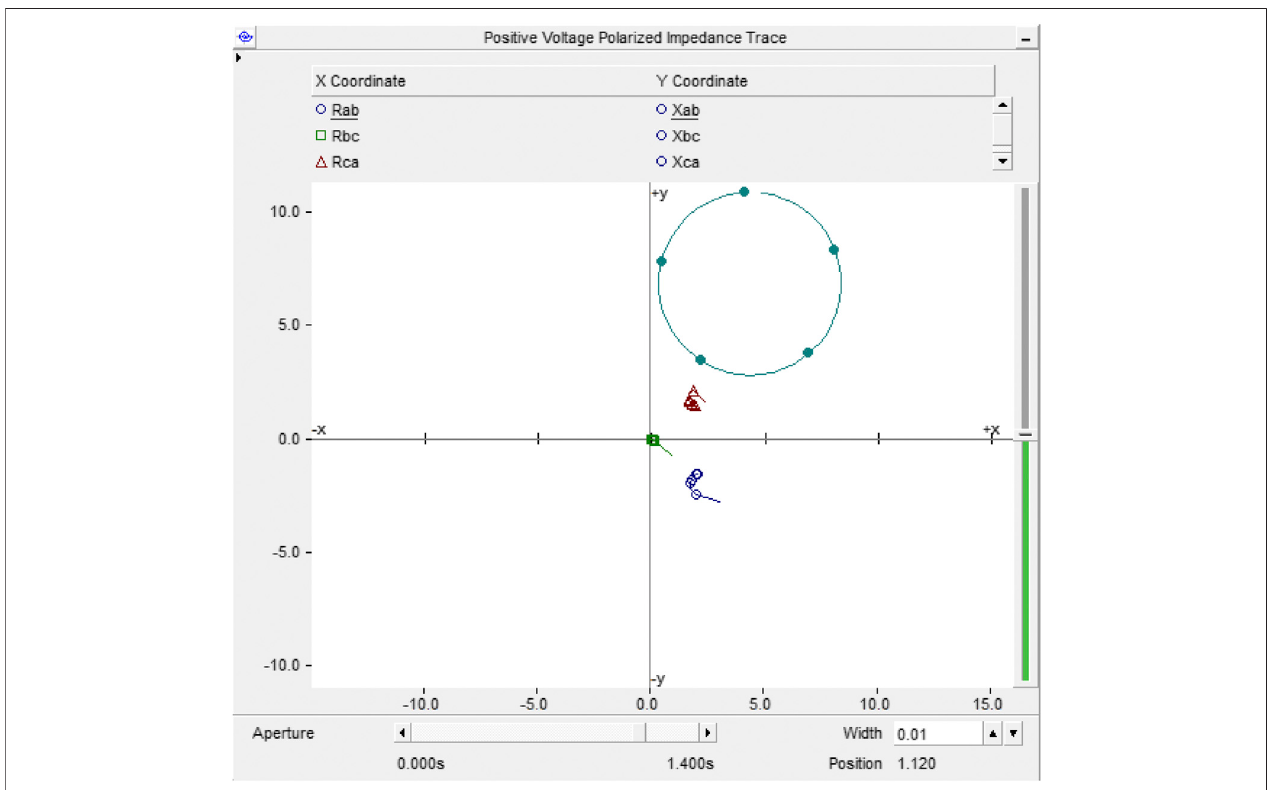
FIGURE7| Whentheprotectionisatthereceivingend,thePCCisconnectedtothegrid.Themeasured impedance trajectoryand operationcharacteristicsofthe positive sequence voltage fault component polarized impedance relay at a BC phase metallic fault 0.1 km backward.